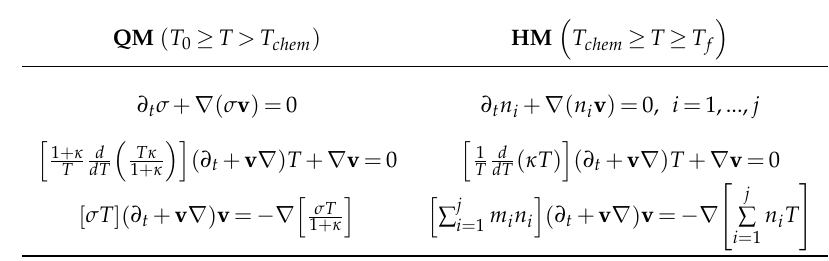
Table 3. The system of partial differential equations that describes non-relativistic fireball hydrodynamics of quark matter (QM) at high, T > T chem temperatures and a hadrochemically frozen, multi-component hadronic matter (HM) at lower, T ≤ T chem temperatures. Similarly to the relativistic case, we have obtained five equations for five unknowns in the high temperature, QM phase, while we have j + 4 equations for j + 4 unknowns in the chemically frozen, multi-component HM phase.